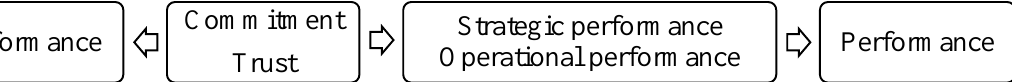
Figure 4. The effect of trust and commitment as a key mediating variable on performance.